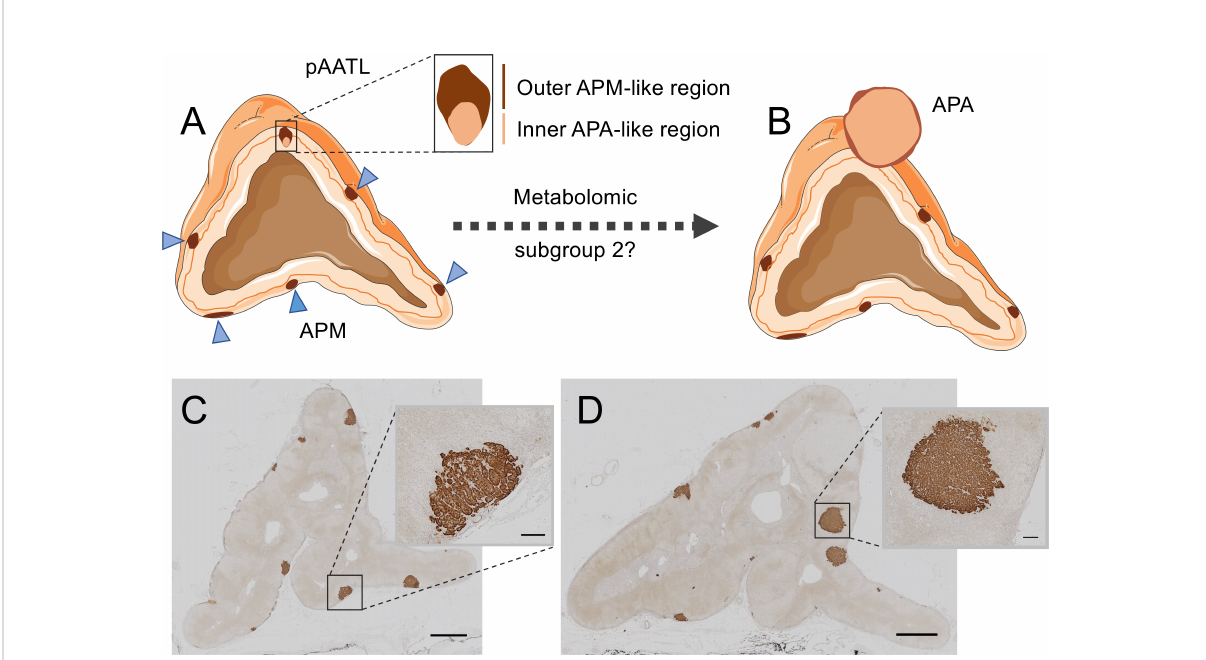
FIGURE 3 Hybrid lesions in the transition of aldosterone-producing micronodules to adenomas. The pAATL is a lesion composed of an outer APM-like region (with positive immunostaining for CYP11B2 but negative for CYP11B1) and an inner APA-like region (with positive immunostaining for both CYP11B2 and CYP11B1) that can have a different mutation status for PA-driver genes (A) . Thus, pAATLs have been proposed as hybrid APM- APA lesions and might represent intermediary lesions in the transit of APMs to APAs. Subgroups of APMs can be differentiated by their highly divergent metabolic pro fi les. A subset of APMs (metabolic subgroup 2) display a metabolic signature like that of APAs and might suggest progression to APAs (B) . CYP11B2 (aldosterone synthase) immunostaining of an adrenal surgically removed from a patient with PA (C, D) . The adrenal in Panel C shows multiple APMs (magni fi ed in inset), a different sample block of the same adrenal in Panel D shows formation of aldosterone-producing nodules (magni fi ed in inset). Bars = 2mm (main image) or 200 m m (inset). Blue triangles indicate APMs in Panel (A) APA, aldosterone-producing adenoma; APM, aldosterone-producing micronodule; pAATL, possible APM-to-APA transitional lesion; CYP11B1, 11 b - hydroxylase; CYP11B2, aldosterone synthase. Figure produced using Servier Medical Art